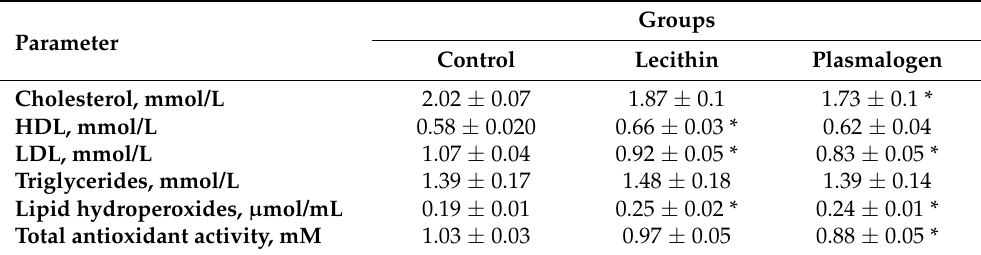
Table 2. Biochemical parameters.